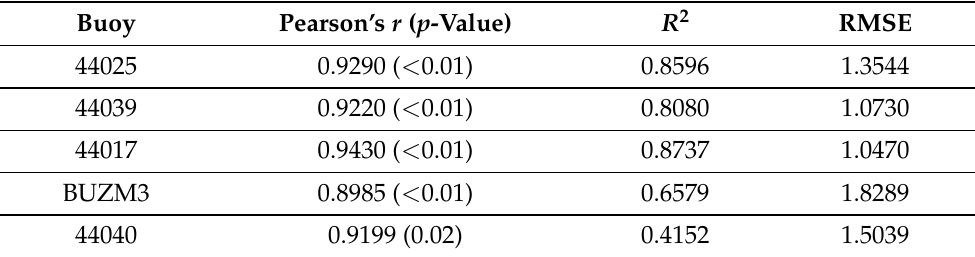
Figure 6. Pearson correlations between SARAL/AltiKa measurements and in situ observations for: ( A ) u 10 ; and ( B ) H s . The circles denote the collecting sample area with radius R p 25 . Table 2. Correlation r , coefficient of determination R 2 and Root Mean Square Errors (RMSE) between in situ and SARAL/AltiKa u 10 measurements for the matched cases.